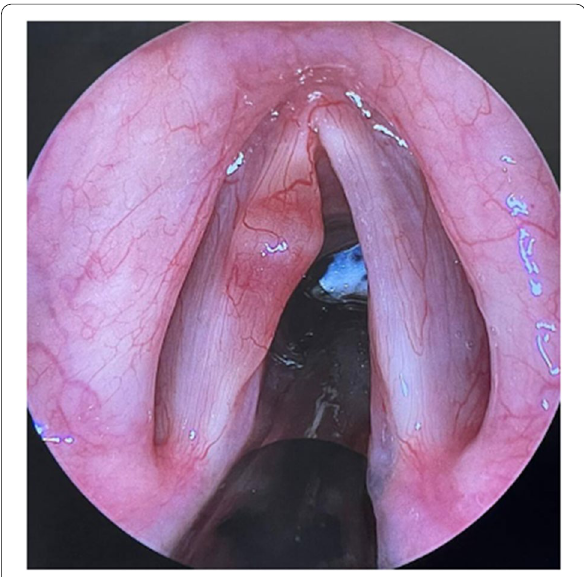
Fig. 2 Direct laryngoscopy view showing fusiform polypoid mass at left vocal fold with prominent overlying blood vessels. Note the fullness surrounding the mass within the superficial lamina propria